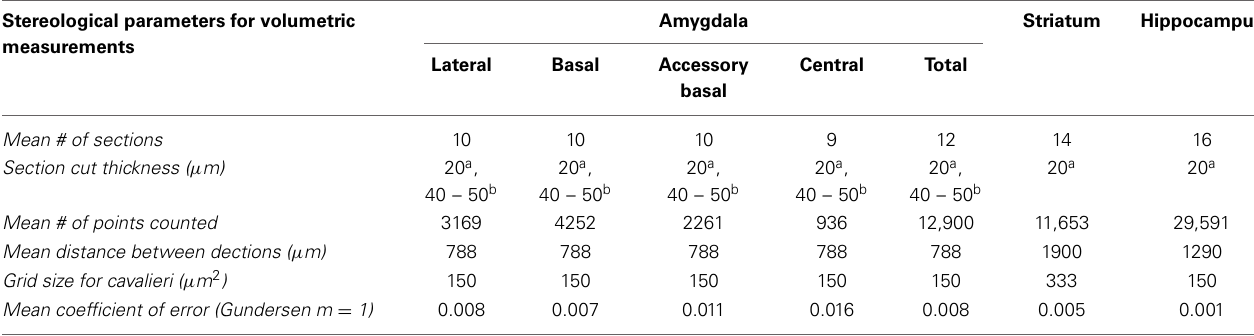
Table 4 | Stereological parameters for the Cavalieri estimator used on new cases for the amygdala, striatum, and hippocampus. Stereological parameters for volumetric